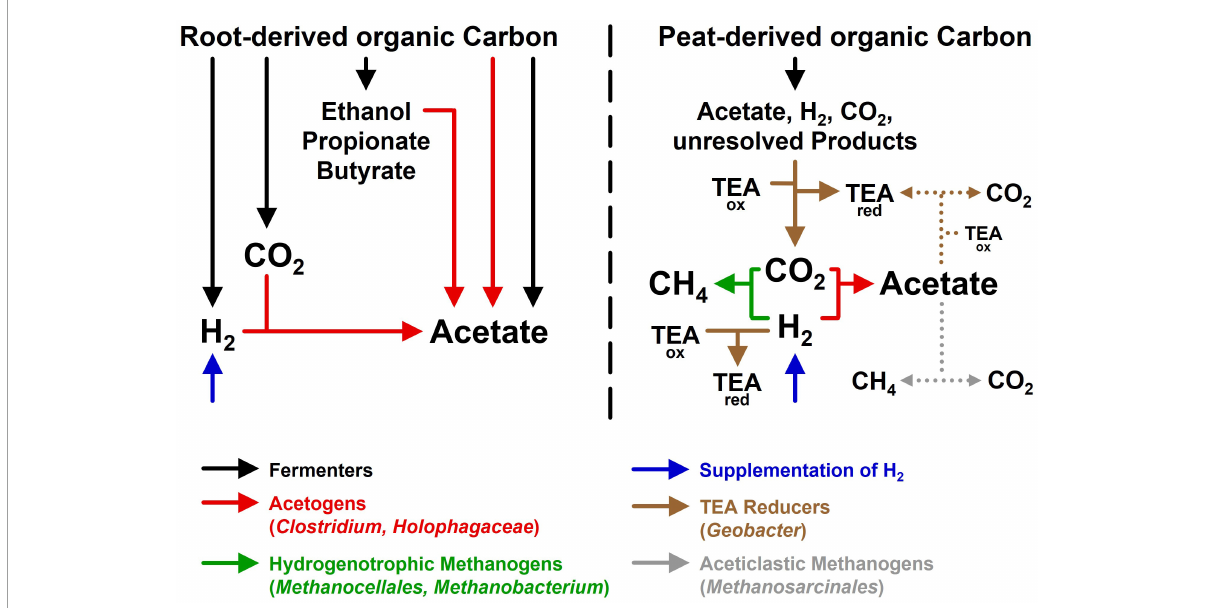
FIGURE5 Hypothetical model summarizing the main processes and taxa observed in root treatments (left) and soil treatments (right). TEA ox , unknown terminal electron acceptors such as ferric iron or sulfate; TEA red , unknown reduced products (e.g., ferrous iron or sulfide) of anaerobic respiratory prokaryotes. Dotted lines indicate that some of the acetate produced by acetogens may have been consumed by aceticlastic methanogenesis or other acetate-consuming processes.